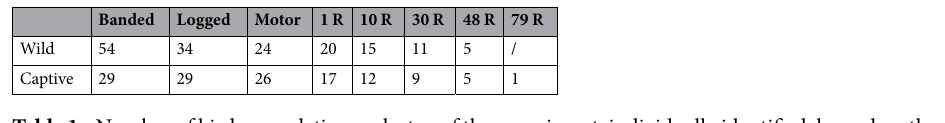
(Contingency table: χ 2 = 0, df = 1, P = 1) and age (Contingency table: χ 2 = 0.52, df = 1, P = 0.41) ratio of birds